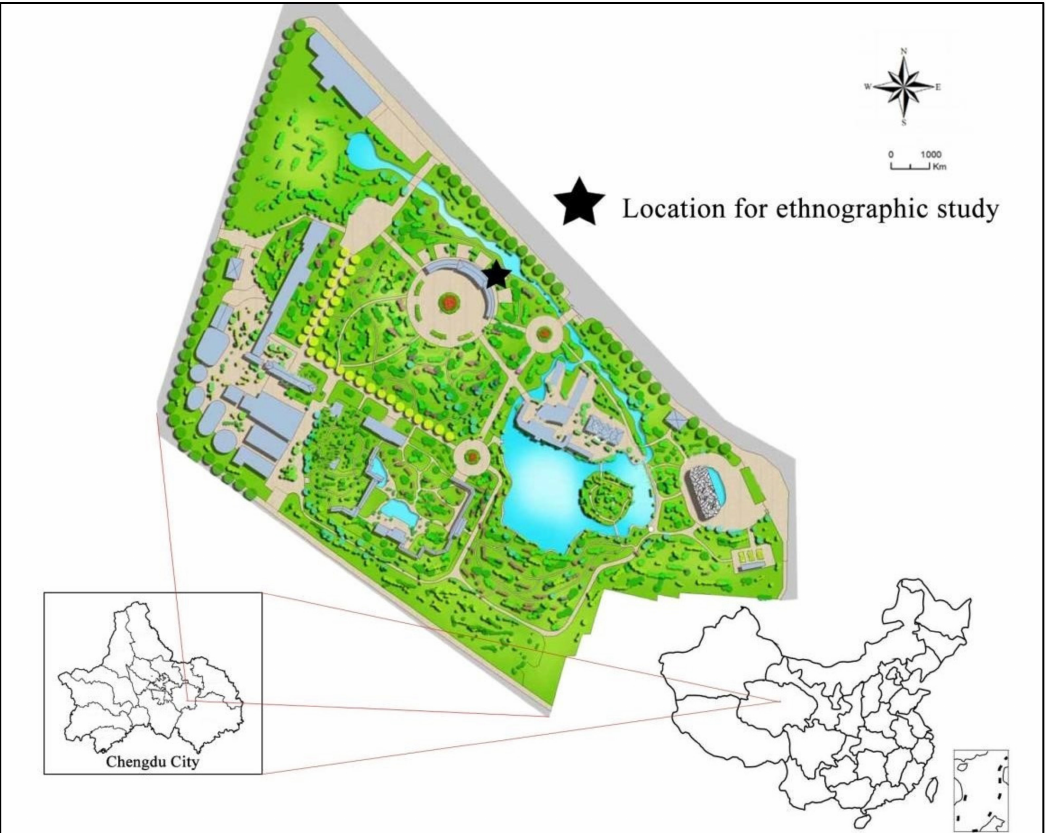
Figure 1. The map of Chengdu People’s Park and the location of the ethnographic study.